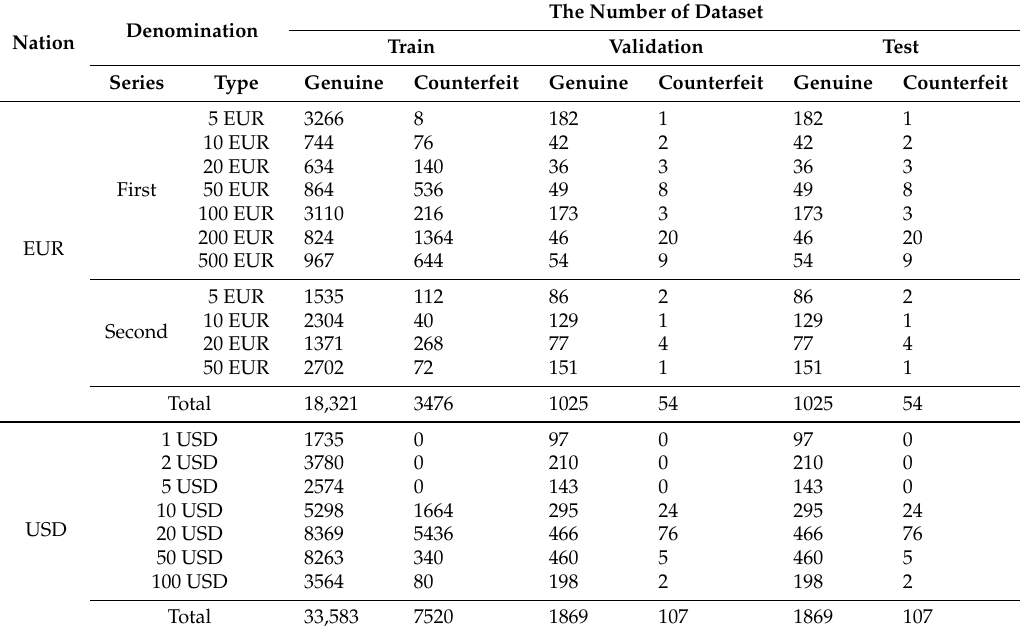
Table 2. Banknote